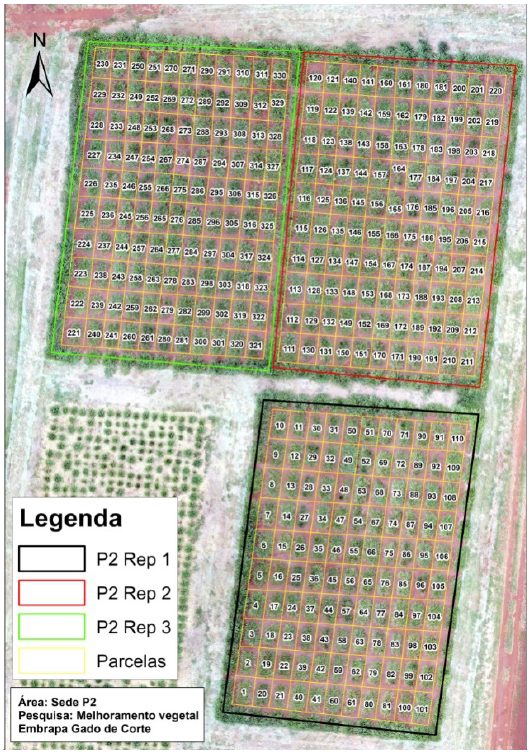
Figure 2. Sketch of the trial in the